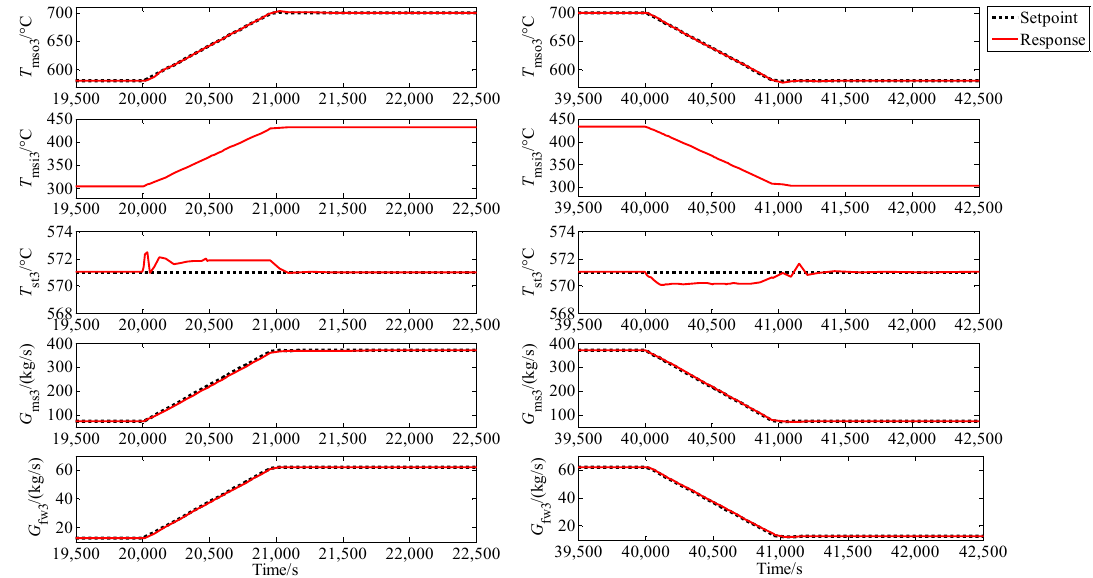
Figure 12. Responses of 1# STP-based OTSSS, T mso3 : receiver outlet molten salt temperature, T msi3 : receiver inlet molten salt temperature, T st3 : live steam temperature, G ms1 : primary molton salt flowrate, G fw1 : secondary feedwater flowrate.